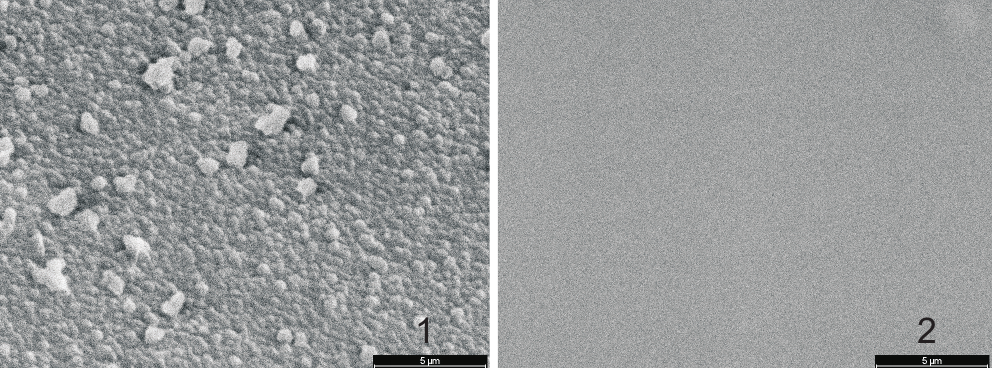
Figure 19. Parylene N, deposited in pure atmosphere of MPX [( 1 ) total pressure: 6 mTorr] and diluted by argon [( 2 ) total pressure: 50 mTorr], scaling bar is 5 µ m. At constant partial pressure of the monomer, the volume polymerization at low pressure is effectively forced